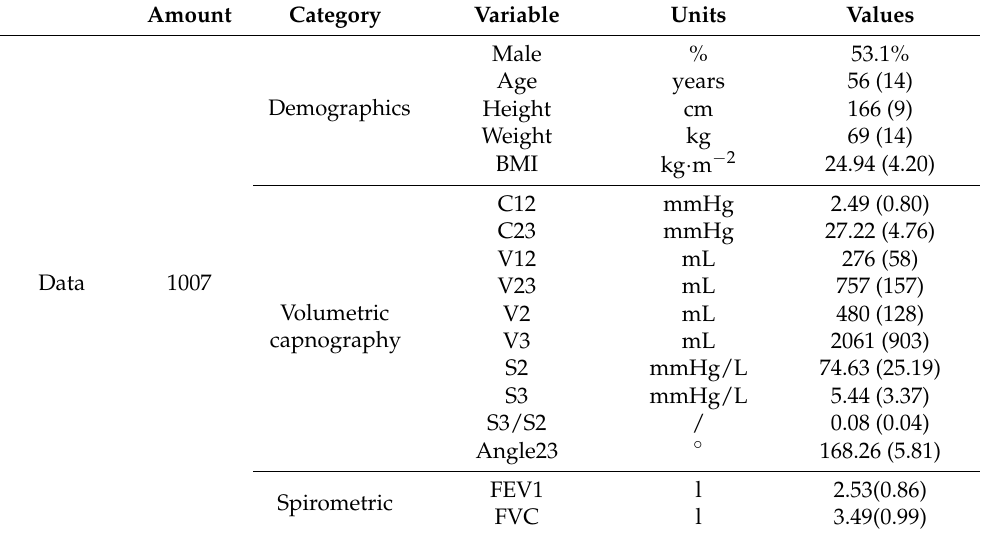
Table 3. Data description